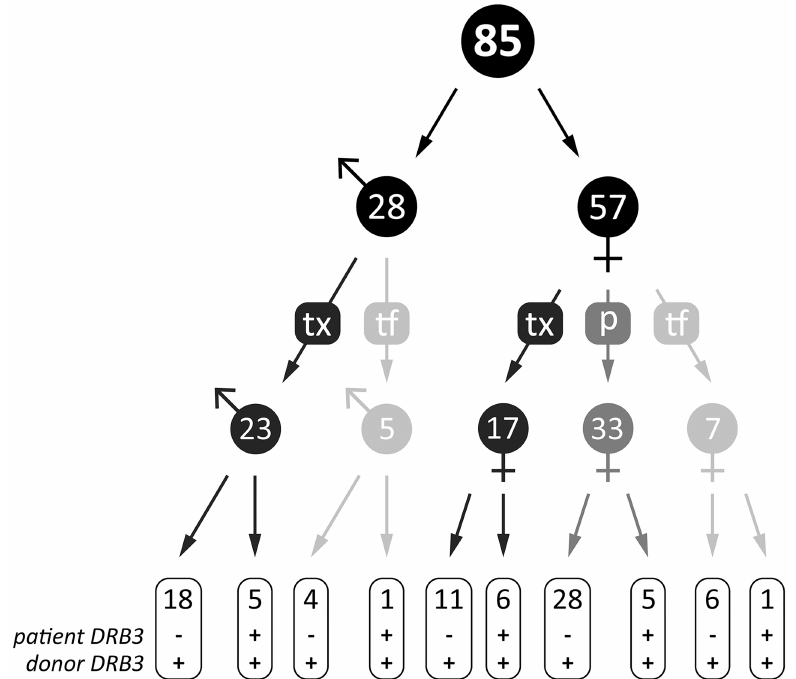
Fig 1. Characterization of 85 positive patients with HLA-DRB3 antibodies based on their immunizing event and whether patients and donors (children in case of pregnancy) were HLA-DRB3 gene carrier or not. We made use of routine antibody screening of patients that undergo or await organ transplantation in the Dutch transplant centers of Maastricht and Groningen. We detected in a total of 85 patients (n = 28 male and n = 57 female; black symbol) HLA-DRB3 antibodies after different immunizing events such as kidney transplantation (tx; dark grey), transfusion (tf; light grey), or pregnancy (p; medium grey). We also determined whether the patients and donors (children in case of pregnancy) were HLA-DRB3 gene carrier or not. Mismatched cases are shown as—for patient DRB3 and + for donor HLA-DRB3 ; and matched cases are shown as + for patient DRB3 and + for donor HLA-DRB3